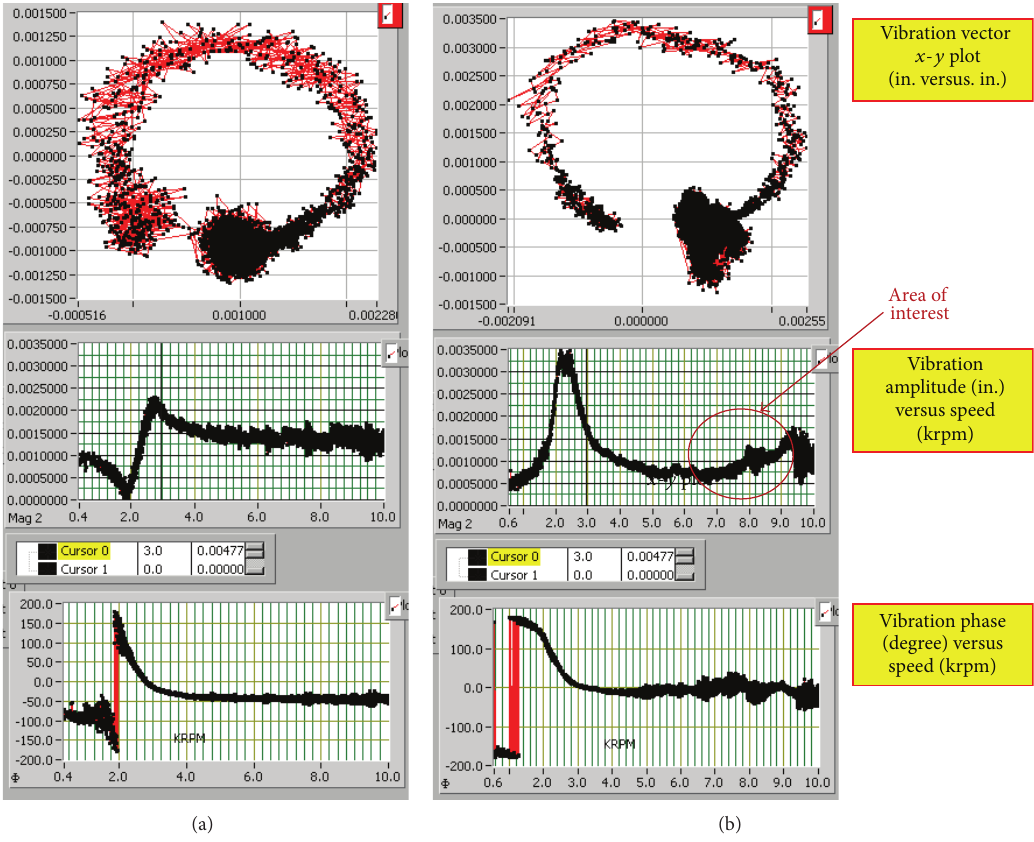
Figure 9: 10000rpm multiple-cycle run comparison. (a) Baseline disk. (b) Notched disk.